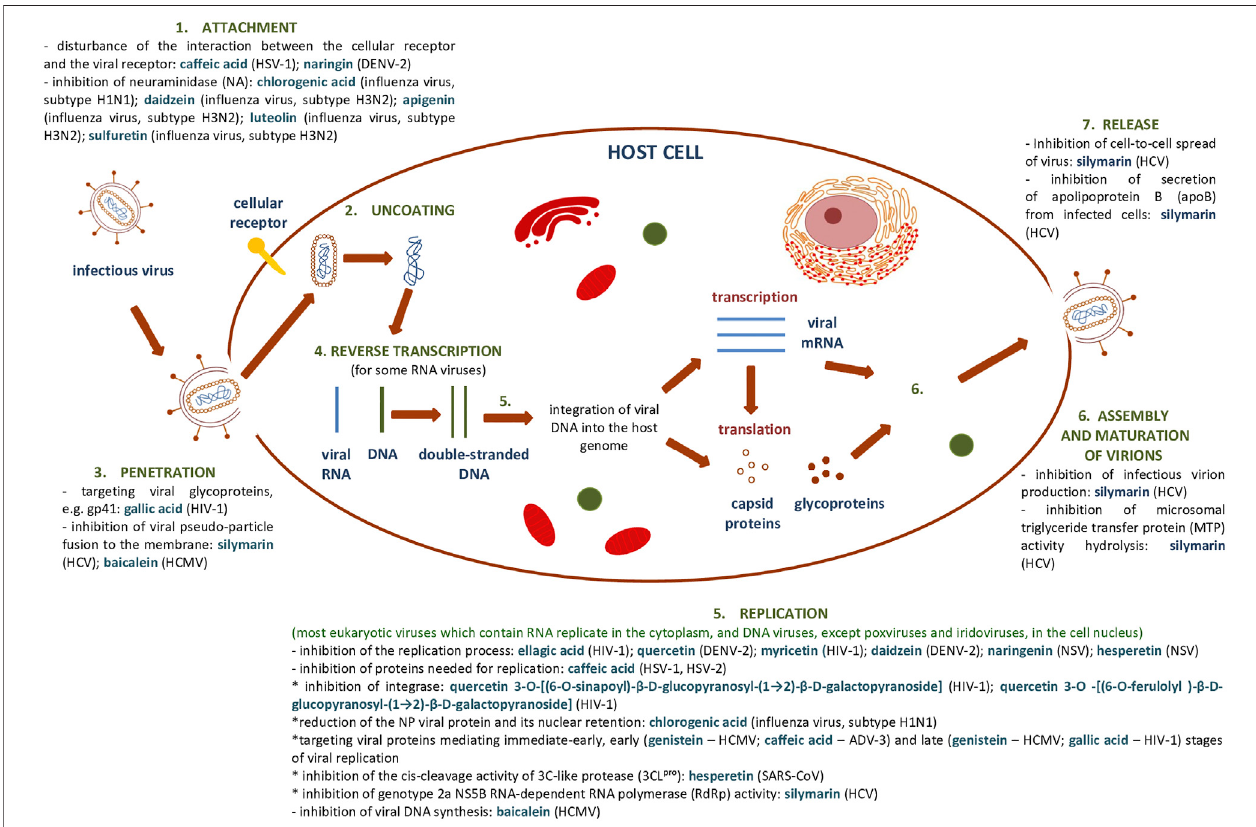
FIGURE7| Generalschemeoftheactionofphenoliccompoundsoneachstageoftheviralreplicationcyclebasedon(Dustinetal.,2016)andcollectedliteraturein this review.